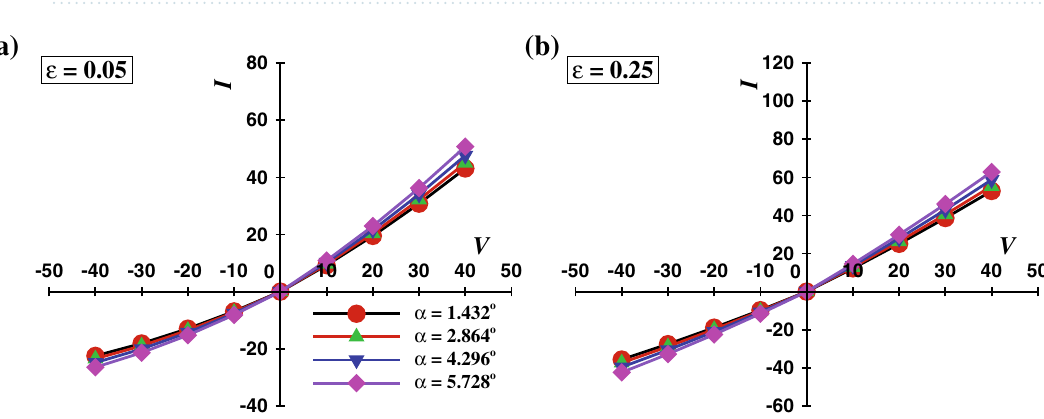
Figure 11. I vs V curve at different values of α at two extreme values of PTT parameter (a) ε = 0.05, and (b) ε = 0.25 at κ R t = 50, De = 100, and σ =